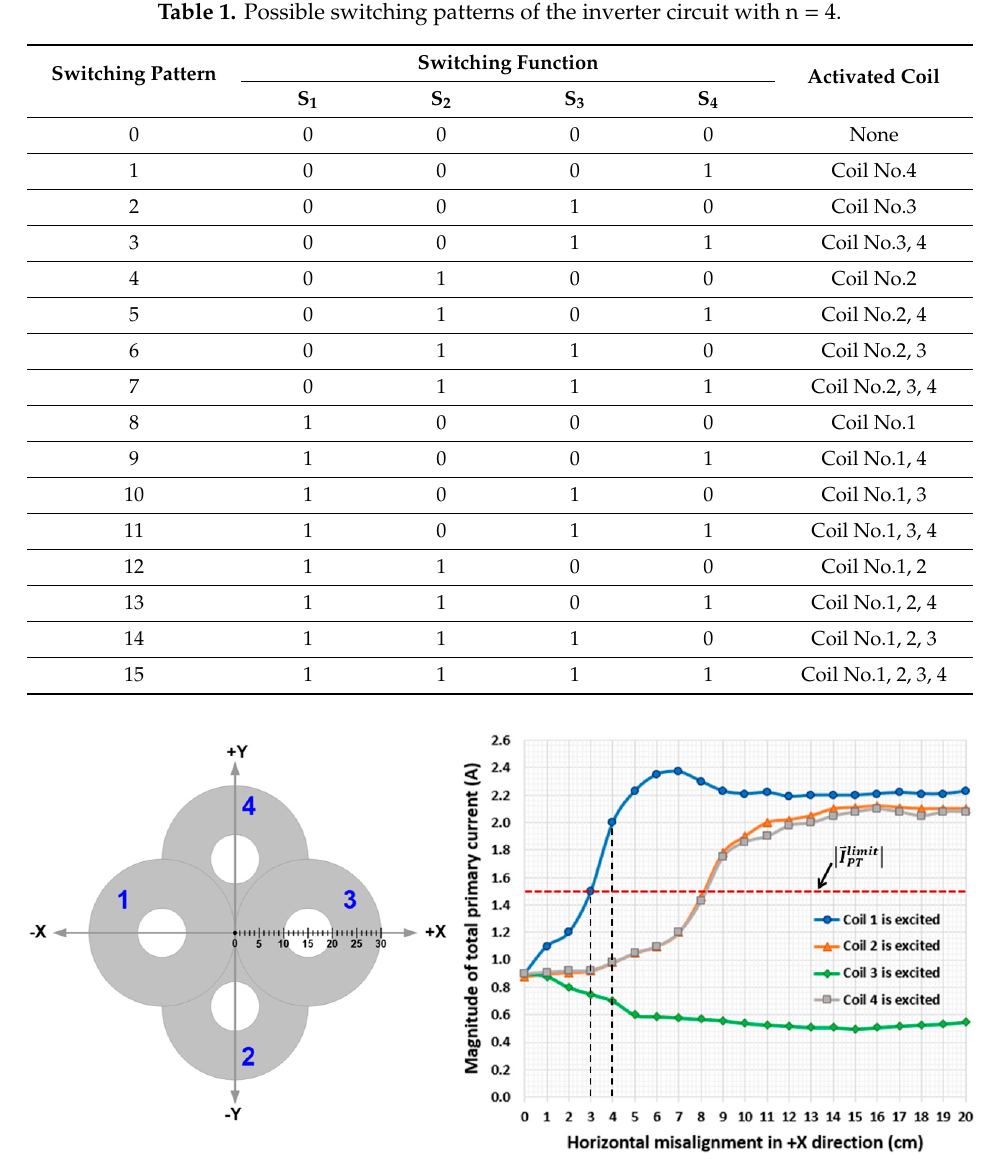
Figure 12. Measured primary current as the receiver coil moved along the + X